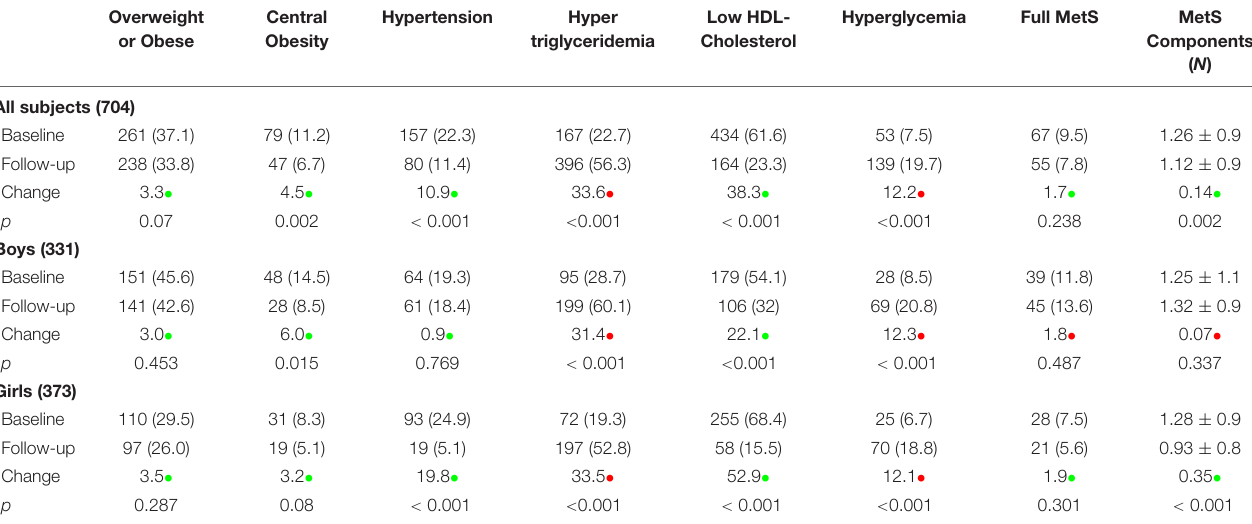
TABLE 4 | Prevalence of MetS and its individual components in Saudi adolescent’s pre- and